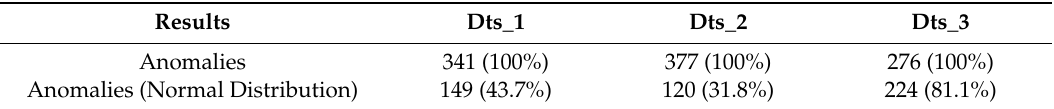
Table 16. Summary of the achieved results and ratios associated to the abnormal